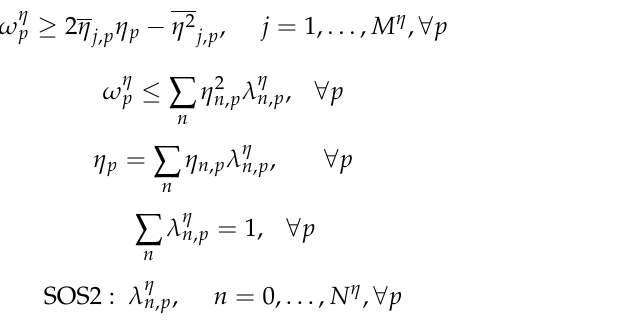
Table 5. Relative differences of the bm , de , nf5 , and nf6t relaxation schemes from an ε -global opti- mal solution with partition size variation.